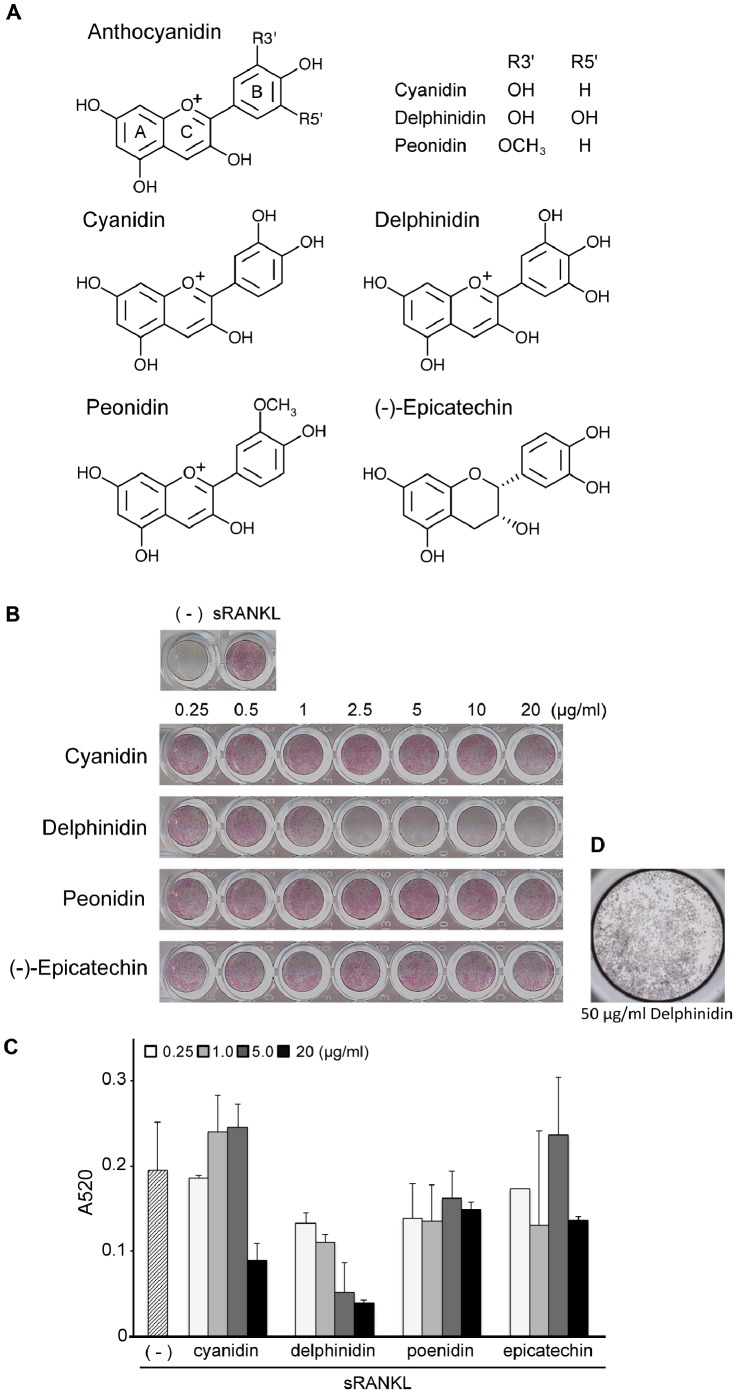
Effects of various anthocyanidins on in vitro osteoclastogenesis.A: The structure of tested three anthocyanidins and (−)-epicatechin as a negative control. B: RAW264.7 cells were pretreated for 1 h with increasing concentrations (0.25–20 µg/ml) of three anthocyanidins and epicatechin, and cultured for 4 days in the presence of RANKL (100 ng/ml). Red-stained area in each well indicates osteoclast population. Delphinidin strongly inhibited RANKL-induced osteoclastogenesis at >1 µg/ml. Cyanidin showed moderate inhibition at 20 µg/ml. C: Absorption ratio also supported the results of TRAP-staining observation. D: RAW264.7 cells were cultured with delphinidin alone for 4 days. No cytotoxic effect of delphinidin was found. Cells were stained by crystal violet.